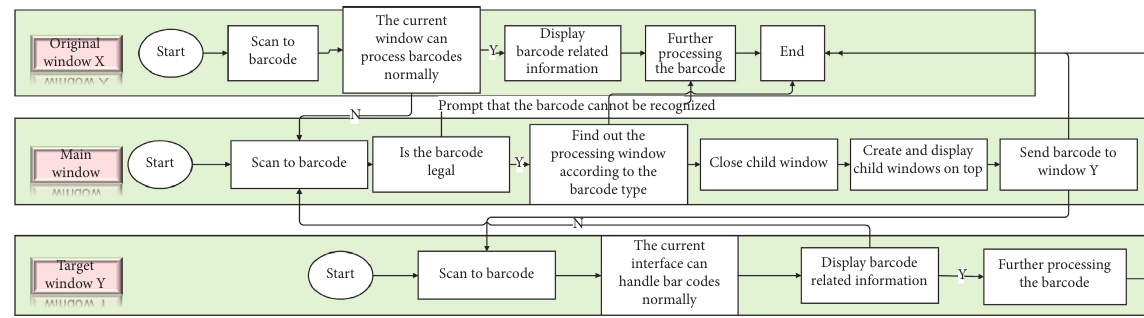
Figure 8: Implementation process of medical order execution management execution. Table 2: Medical order information management test table and test